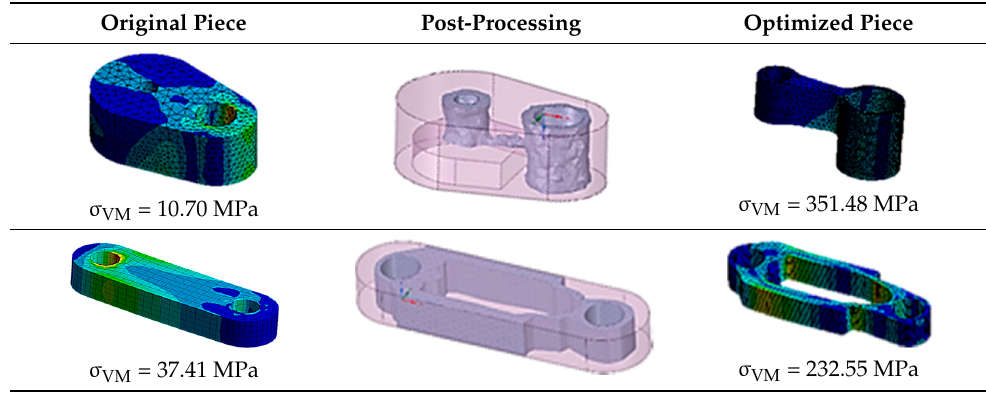
Table 6. Results of the six-bar mechanism.